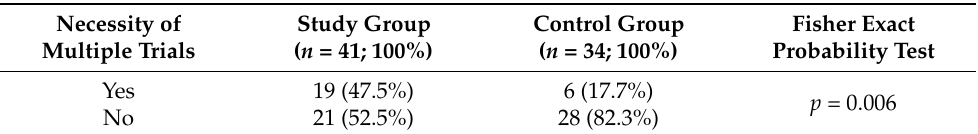
Table 5. The necessity of conducting multiple trials in introducing new foods in the study group the and control group (question I/8).